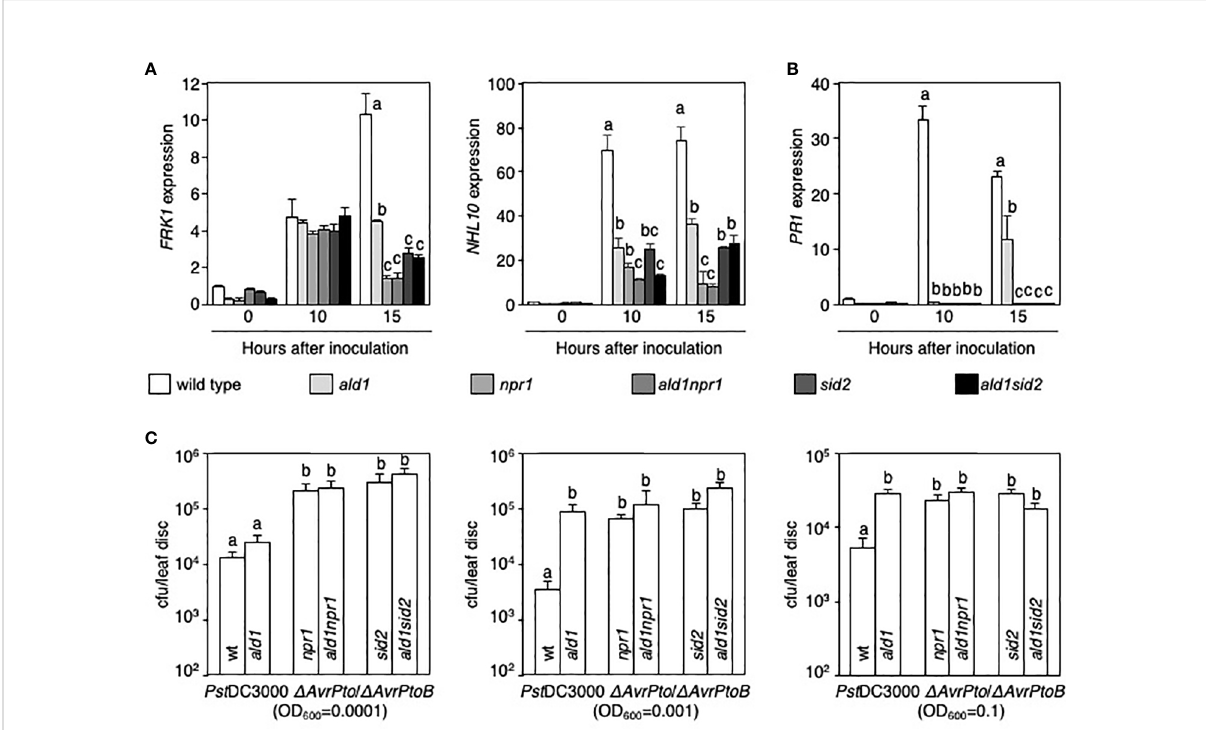
FIGURE 2 Mutations of ALD1 , NPR1 , and ICS1 / SID2 cause hypo-resistance against an attenuated strain of Pseudomonas syringae infection. (A, B) Relative expression levels of FRK1 and NHL10 (A) and PR1 (B) in leaves of WT and mutants infected with Pst DC3000 D AvrPto / D AvrPtoB (OD 600 = 0.01). The columns and bars show the average with standard deviation obtained from three biological replications (number of technical replicates = 3). (C) Growth of Pst DC3000 D AvrPto / D AvrPtoB strain in WT and mutants. An attenuated strain was syringe-in fi ltrated into the leaves of WT, single, and double mutants (OD 600 = 0.0001 or 0.001) (left and middle panels), or the strain was also applied to Arabidopsis plants with a spray (OD 600 = 0.1) (right panel). The number of bacteria was counted on day 3 or 5 after inoculation. Error bars indicate standard error (n = 10 or 12). The experiment was repeated twice with the same results. Statistically signi fi cant differences are shown using different letters ( p < 0.05 [ A , B ], p < 0.01 [ C ], one-way